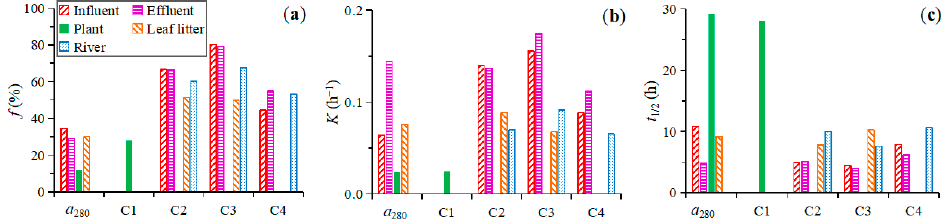
Figure 5. The photodegradable fraction ( f , ( a )), decay rate ( k , ( b )), and half-life ( t 1/2 , ( c )) of the bulk CDOM ( a 280 ) and each fluorescent component (C1–C4) from different sources.